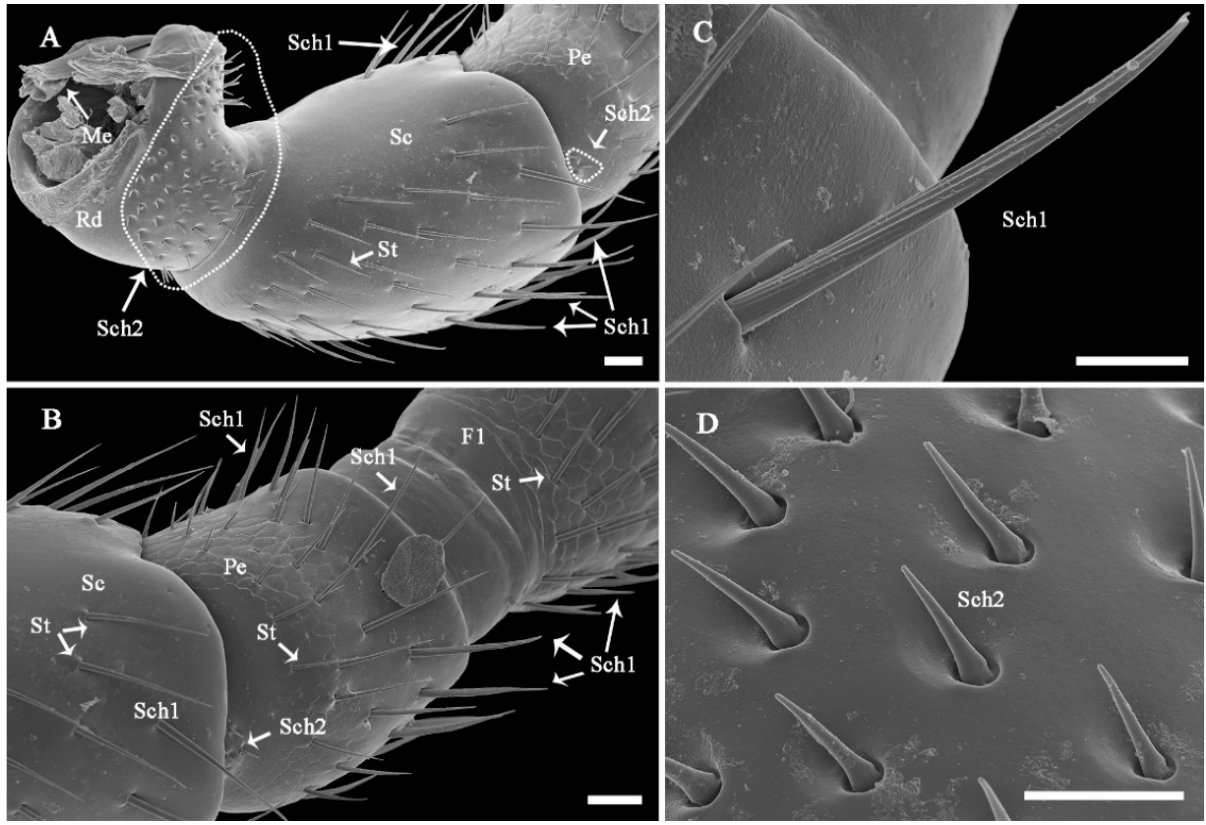
Figure 6. Fine morphology and distribution of antennal sensilla on antennal bases of C . qinlingensis .